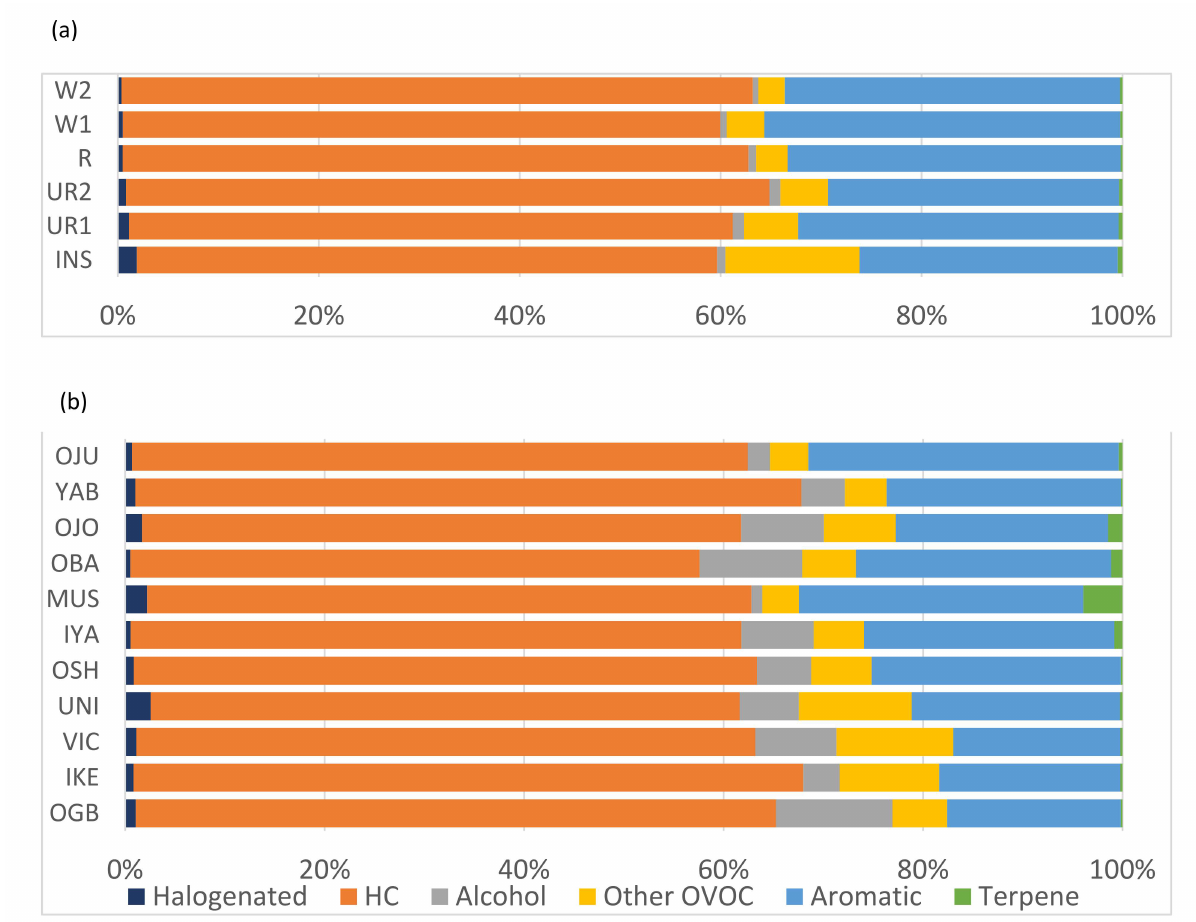
Figure 3. Total VOCs composition by chemical class across all measurement sites in ( a ) Nairobi and ( b )